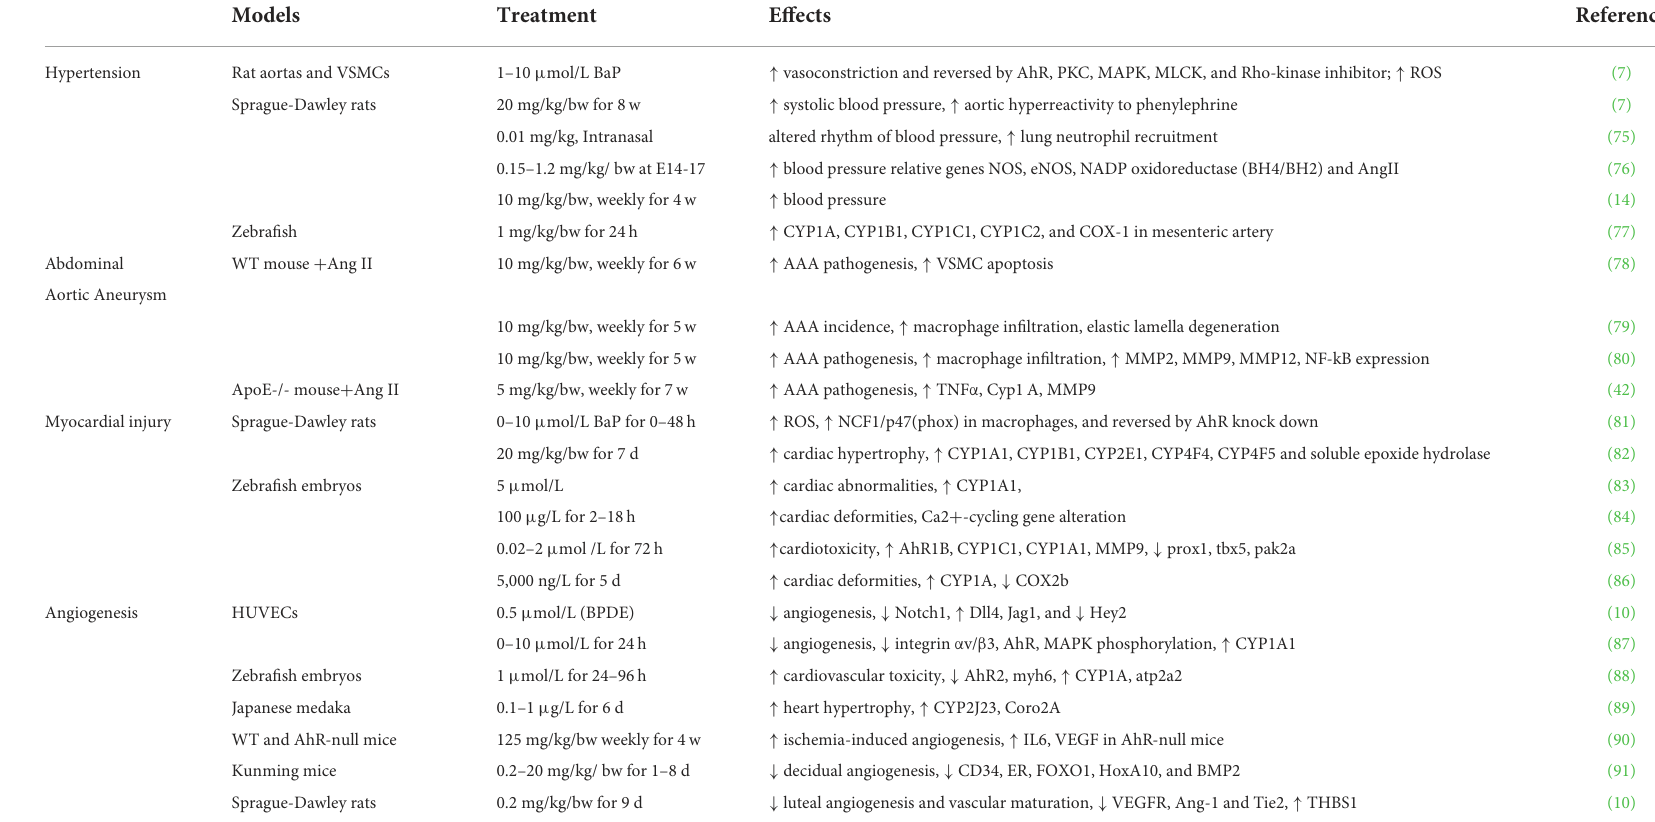
TABLE 2 Effects of BaP on HTN and